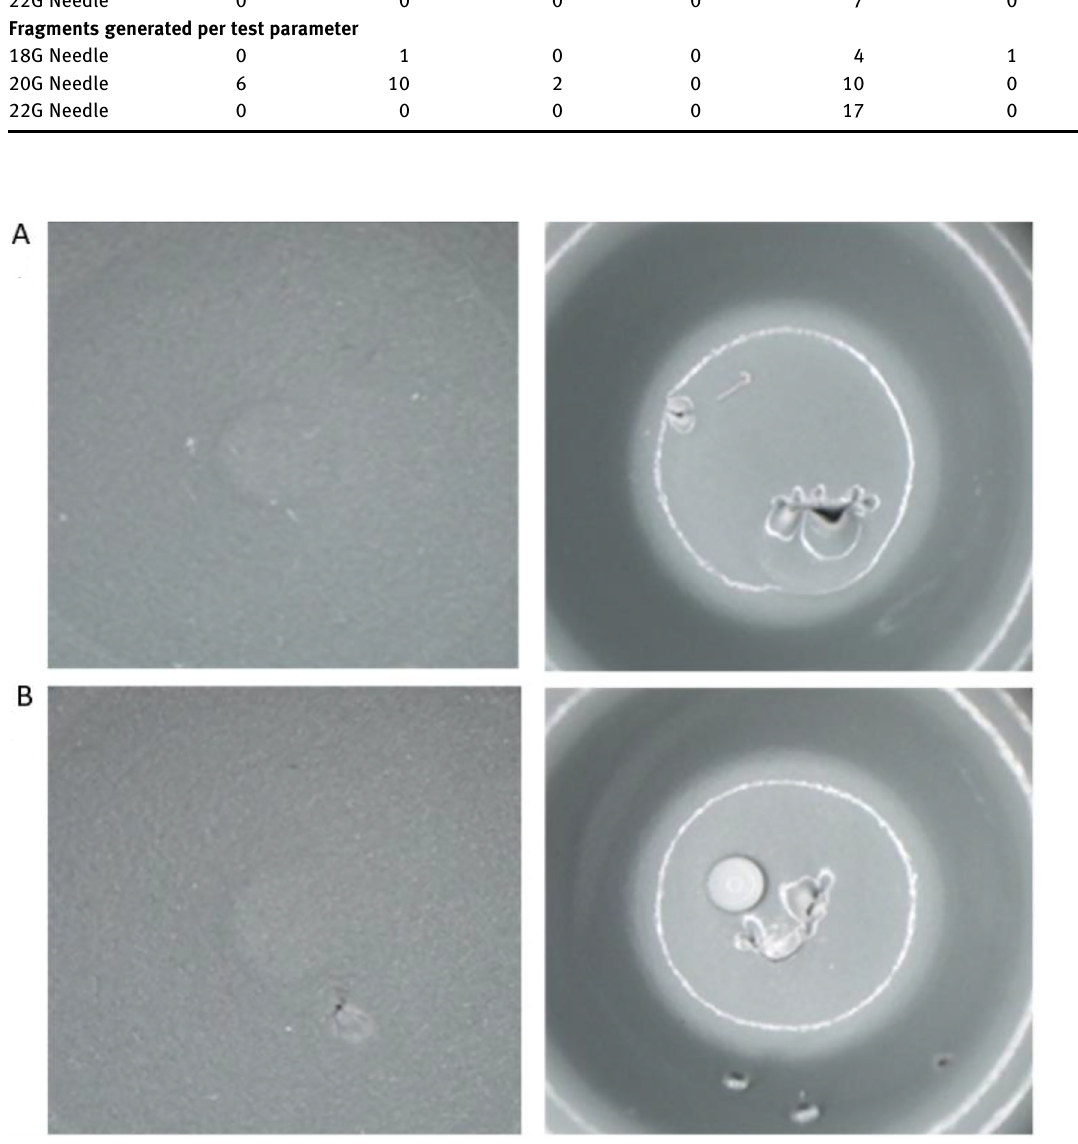
Figure 3: Images viewed under 10 × eyepiece lens, 1 × objective lens, and zoomed 8 × for a total magni fi cation of 80 × (A) non-fragmenting stopper surface (left) and underside (right); (B) fragmenting stopper surface (left) and underside